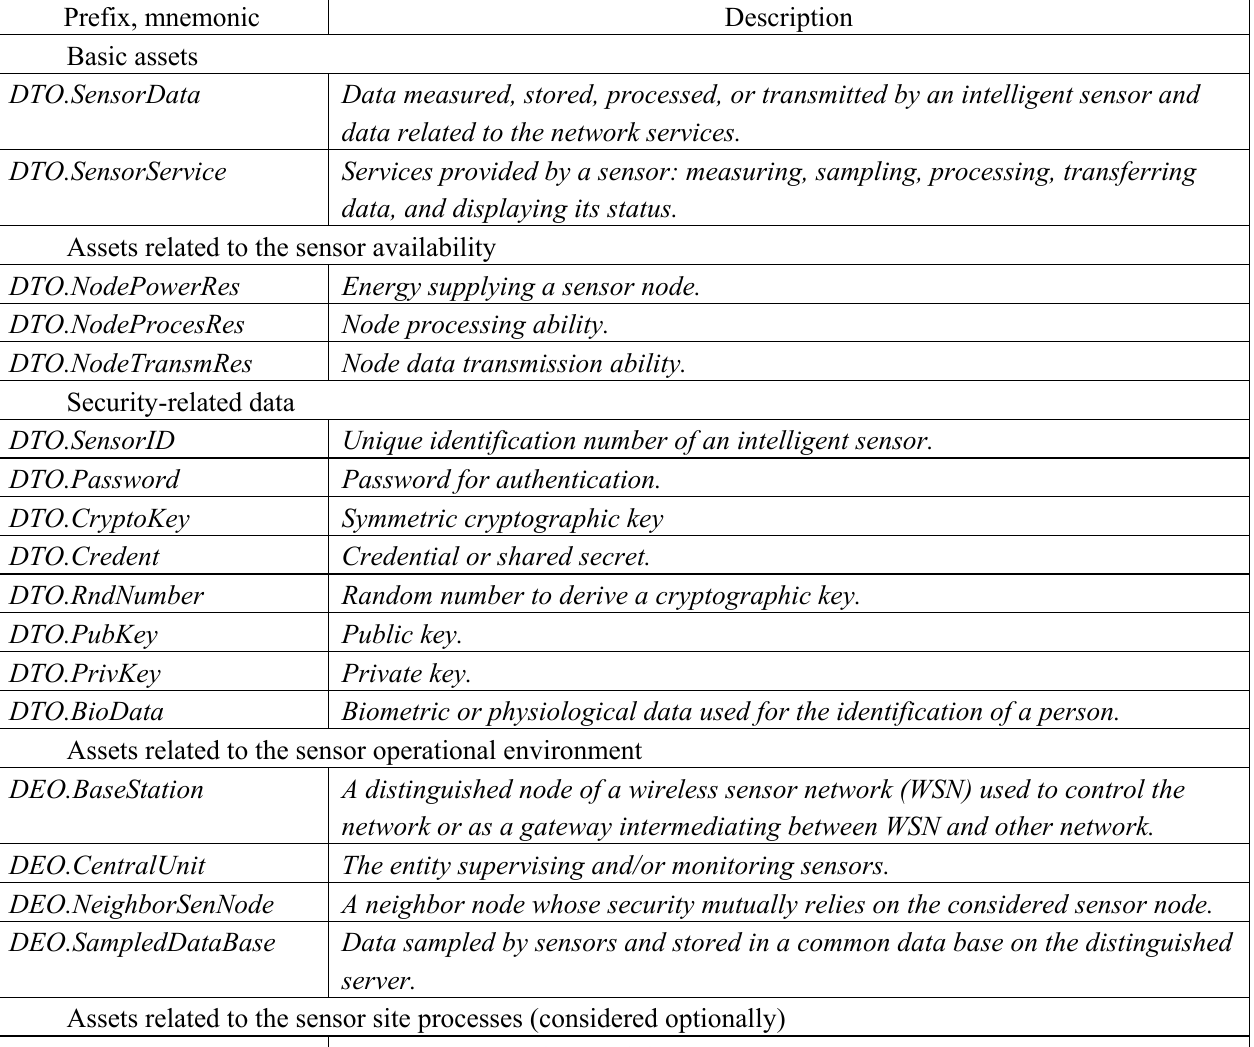
Table 8. Enhanced generics representing protected assets and other passive